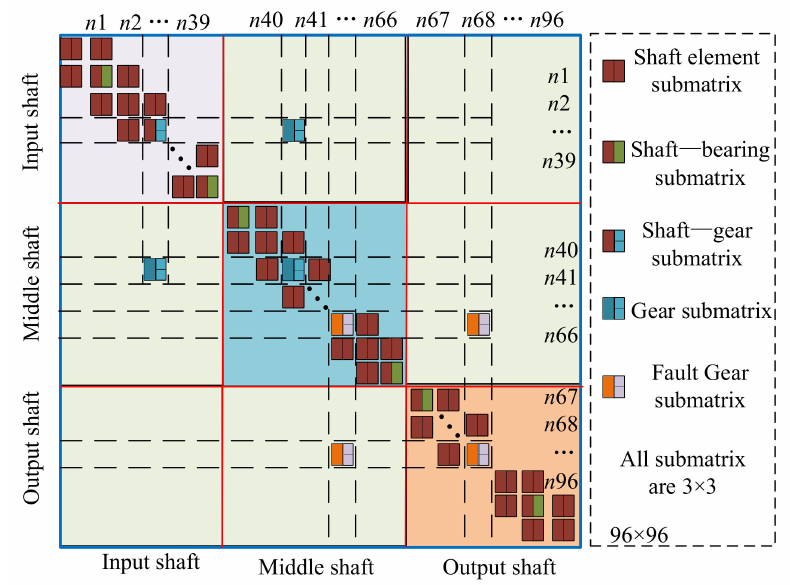
Figure 21. Total stiffness matrix of transmission